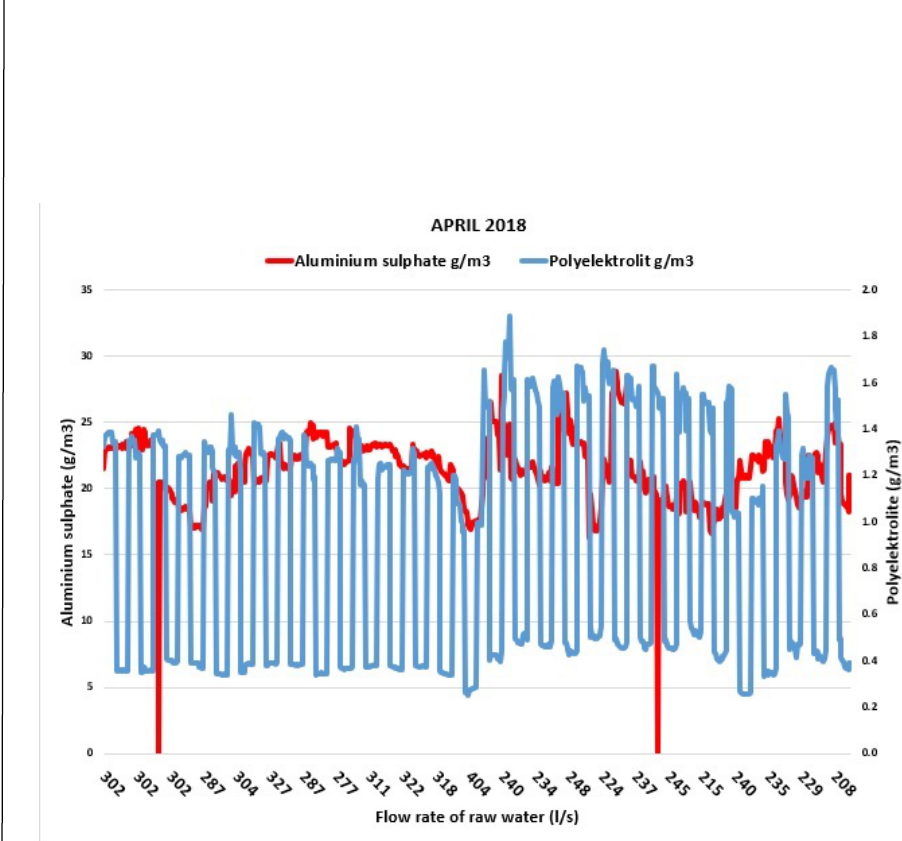
Figure 5b – Dependence of the concentration of added aluminum sulphate and polyelectrolyte on the flow rate of raw water during April 2018 Рис . 5 б – Взаимозависимость концентрации добавленного сульфата алюминия